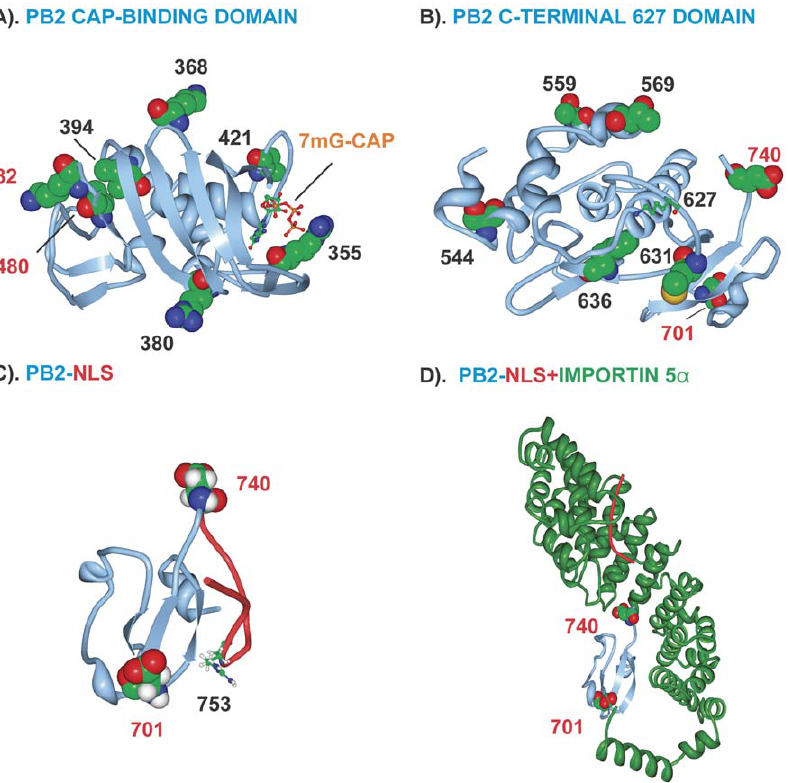
Figure 3. Mouse adaptive mutations on PB2 three dimensional maps. Mutation sites are shown on ribbon structures of PB2 protein with space filling models of amino acids numbered in black for mutations found once, or red for positively selected mutations. (A) PB2 cap binding domain bound to m7GTP (in stick image); (B) PB2 C-terminal domain with the 627 site shown in stick image. (C) PB2 NLS with R753 (stick image) that forms a salt bridge with D701, NLS in red; (D) PB2 NLS in complex with human importin a 5; NLS in